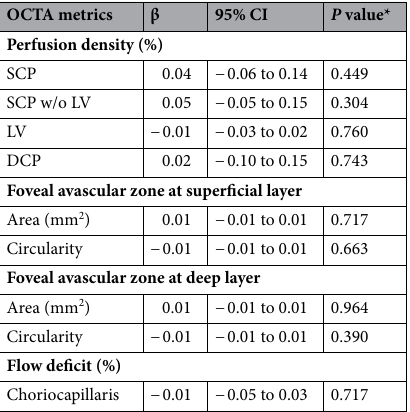
Table 5. Univariate analysis of optical coherence tomography angiography parameters with number of MS episodes. CI confidence interval, DCP deep capillary plexus , LV large vessels, OCTA optical coherence tomography angiography, SCP superficial capillary